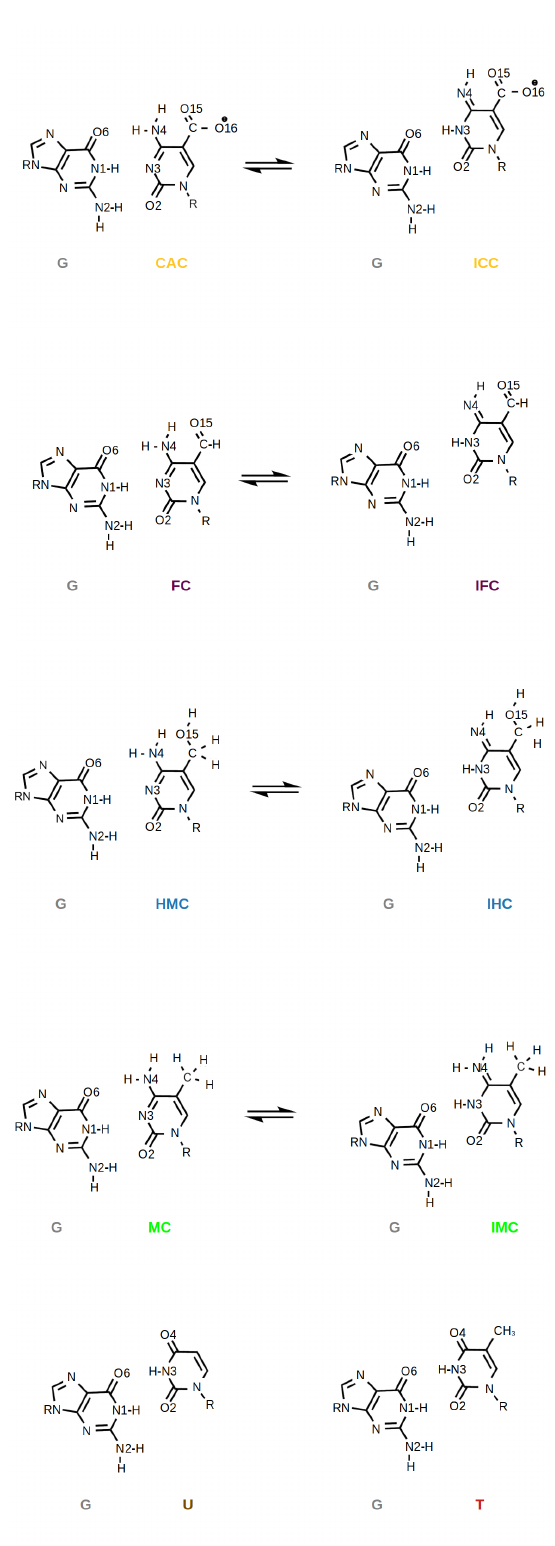
Figure 2. Amino and imino forms of oxidised methyl-cytosines CAC, FC, HMC, and MC paired with guanine, G, and, for comparison, the G:U and G:T